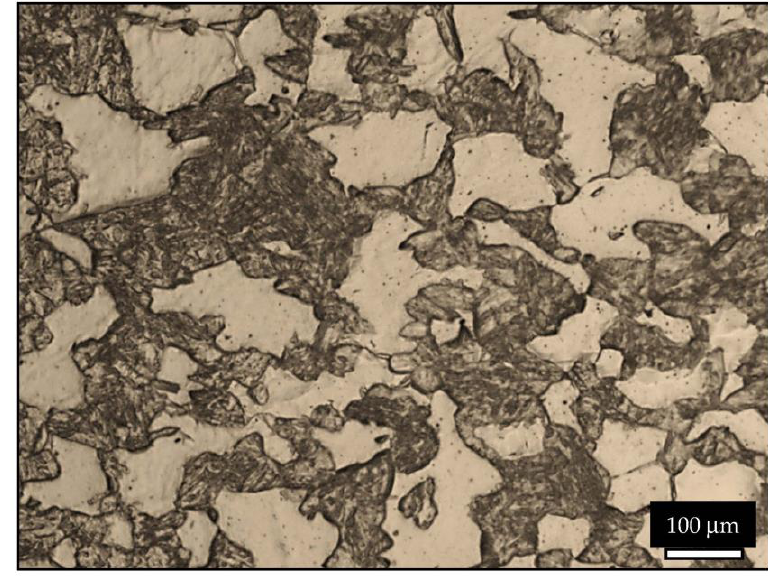
Figure 3. Microstructure of DP rebar produced by heat treatment.